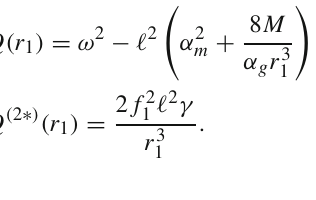
6 QNMs of dRGT black strings with negative (cid:3) : spectral